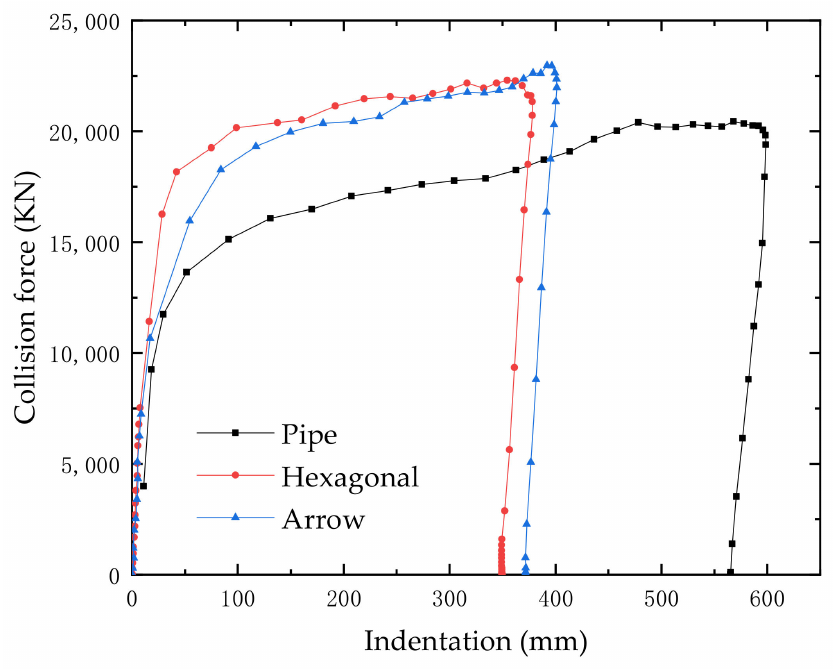
Figure 13. Collision force–indentation curves of different structures at 2